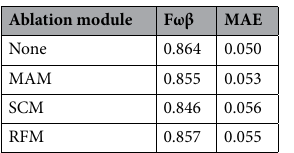
Table 2. Fωβ ↑ and MAE ↓ values for ablation experiments on the ECSSD